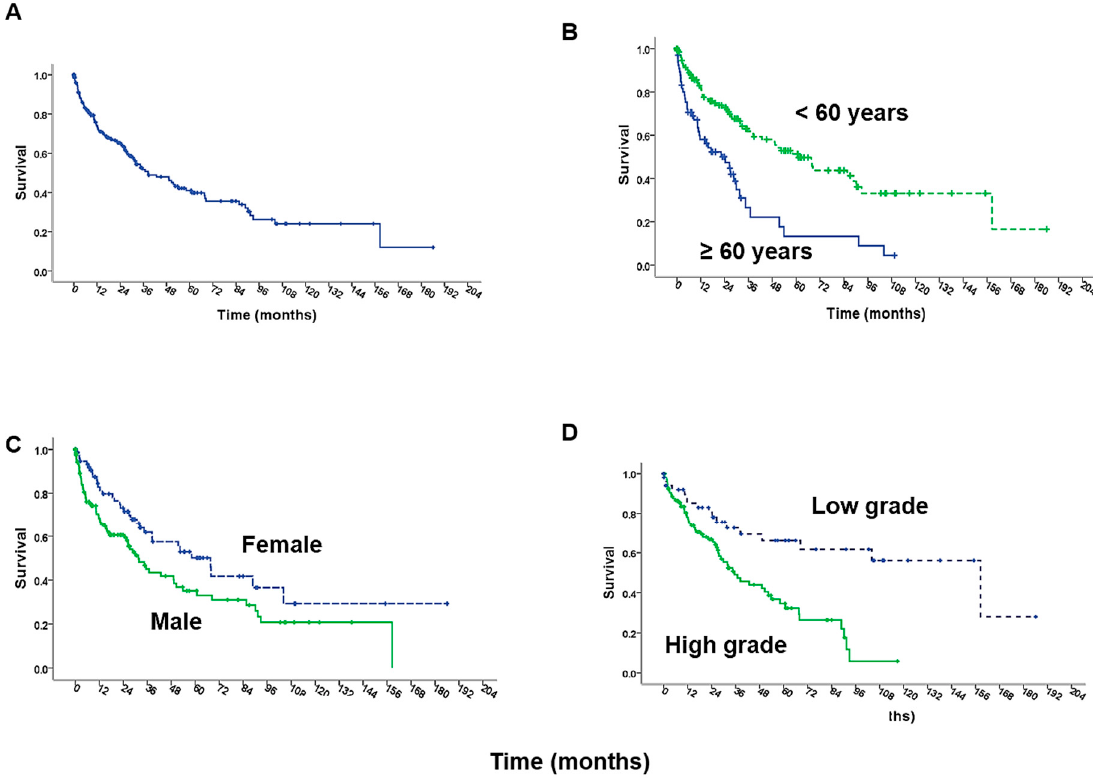
Figure 2. Actuarial overall survival in 211 MPM patients after CRS and HIPEC ( A ) and based on age ( B ), gender ( C ), and histologic grade ( D ). (Reprinted with permission from Alexander et al. [32]. Copyright 2013 Mosby, Inc.).